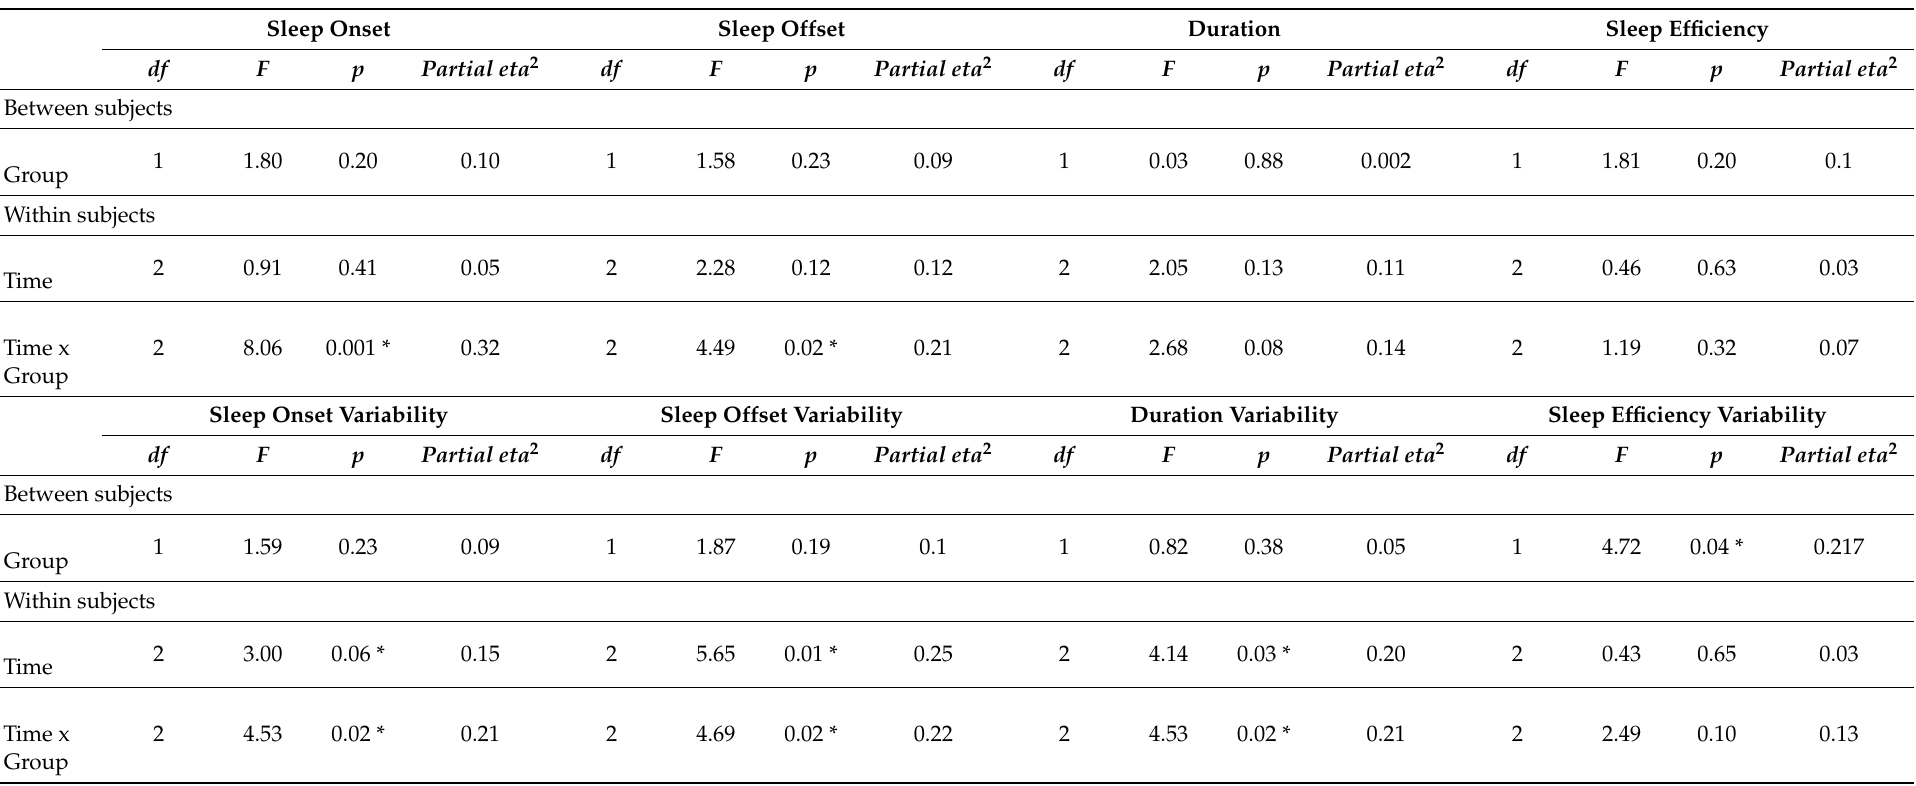
Table 3. Mixed ANOVA results for sleep outcomes by group ( FIRST Patients vs. Comparison Group ) across time points. Sleep